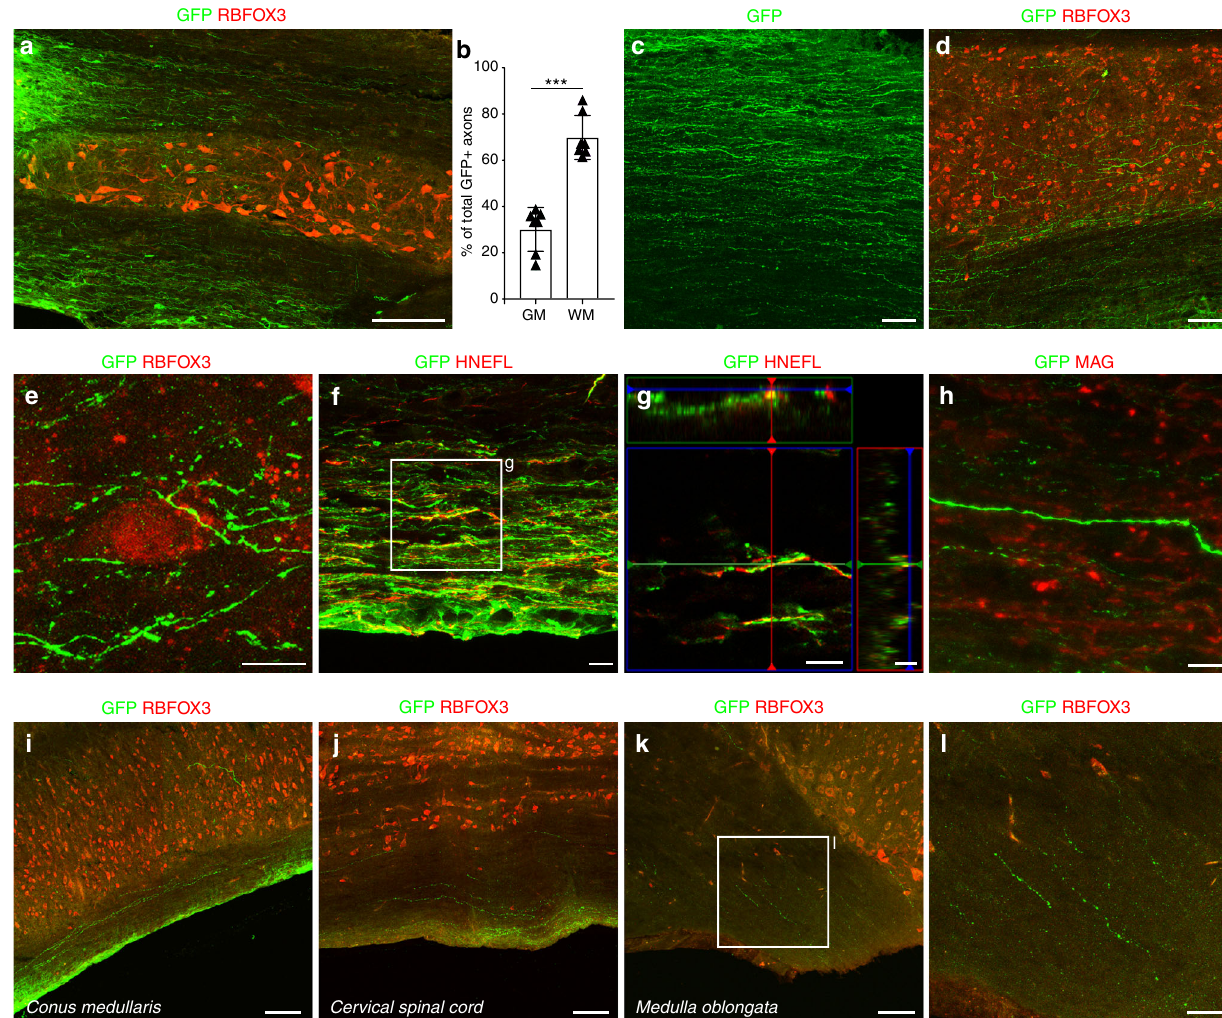
Fig. 3 Extensive axonal outgrowth from human SC-NES cell grafts. a GFP and RBFOX3 immunolabeling on a horizontal section of SC grafted with SC-NES cells. GFP-expressing cells show a massive axonal elongation rostral and caudal to the trauma site (caudal shown). b Quanti fi cation of graft-derived axons in the gray (GM) and white matter (WM) of the recipient SC showing a preferential axonal growth in the WM. c , d GFP-positive axons grow in a parallel pattern in the WM and acquire a more rami fi ed morphology in the GM identi fi ed by the RBFOX3 staining. e GFP-expressing axon terminals are closely associated with host RBFOX3-positive neurons. f , g GFP-labeled projections arising from the graft express human neuro fi lament (HNEFL), con fi rming their identity as axons. h GFP and myelin associated glycoprotein (MAG) staining reveals a lack of myelination of the human fi bers. i – l GFP and RBFOX3 staining of the recipient SC at different levels. Human GFP-positive axonal fi bers elongate throughout the entire length of the SC from the original injection site in the thoracic segment. GFP-positive axons can be found in the cervical portion and more rostrally in the medulla oblongata . Human axons also grow caudally reaching the conus medullaris . Data are expressed as mean ± s.e.m (*** P < 0.001; Student ’ s t -test). Scale bars: a 200 µ m; c , d 50 µ m; e 10 µ m; f – h 10 µ m; i –